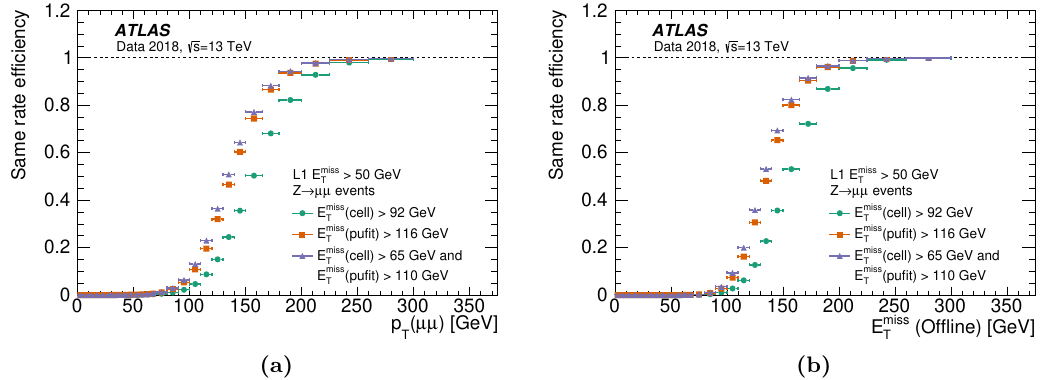
Figure 7. Turn-on e(cid:14)ciency curves are shown for Z ! (cid:22)(cid:22) events for three algorithms: the cell algorithm alone, the pufit algorithm alone and the combined cell + pufit algorithm. The thresholds are set such that the algorithms have equal rates, and the data were recorded in the year 2018. (a) The trigger e(cid:14)ciency with respect to p T ( (cid:22)(cid:22) ) . (b) The trigger e(cid:14)ciency with respect to the o(cid:15)ine E miss calculation with muons treated as being T